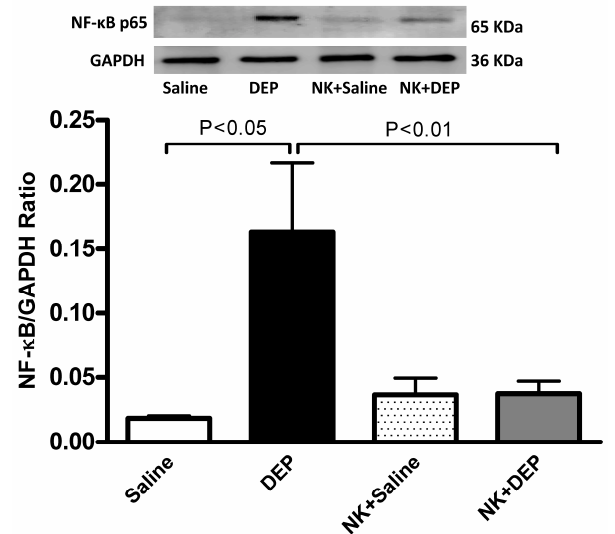
Figure 7. Nuclear factor-kappaB (NF- κ B) levels in the lung tissues determined by Western blotting, 24 h after intratracheal instillation of either saline or diesel exhaust particles (DEP, 30 µg/animal), with or without nootkatone (NK) pretreatment. Data are mean ± SEM ( n = 4 in each group).